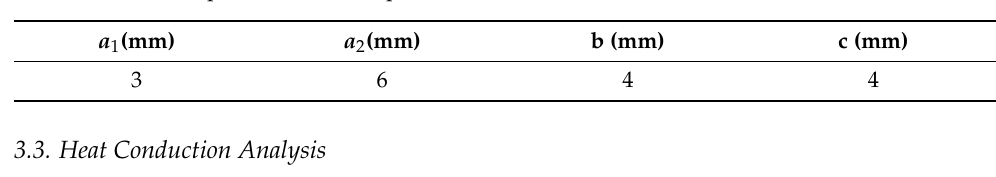
Table 3. Double ellipsoid heat source